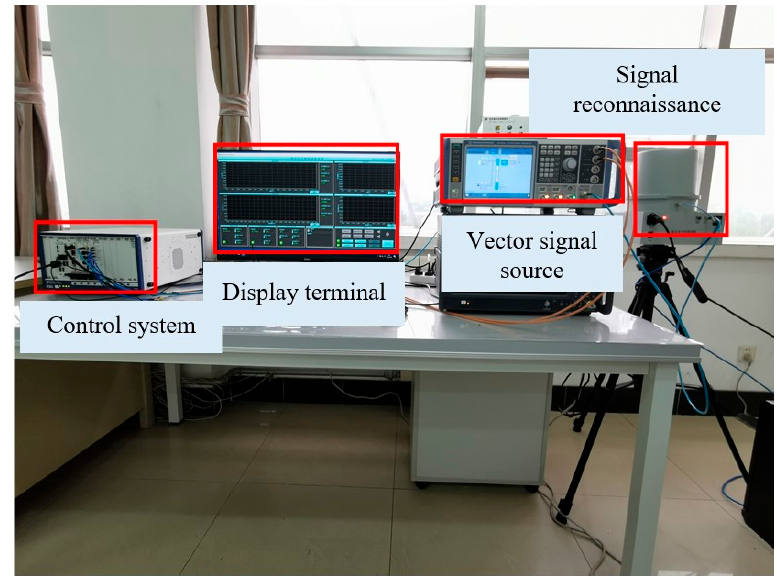
Figure 12. Signal sorting experiment equipment connection diagram.